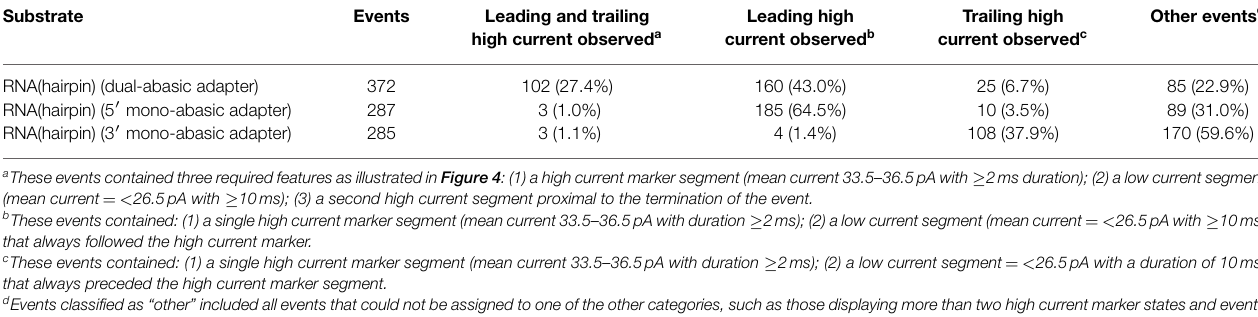
TABLE 1 | RNA(hairpin) nanopore translocation events classified by detection of leading and trailing high current markers .